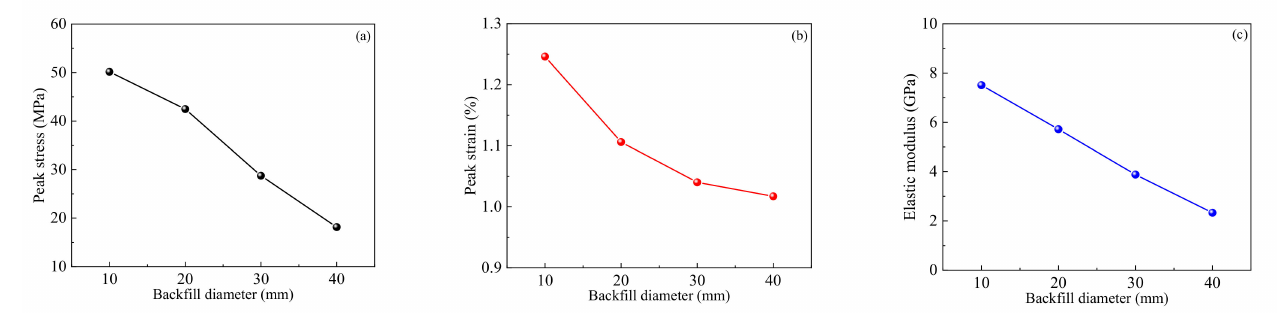
Figure 6. The relationship between the mechanical properties and backfill diameter: ( a ) the σ p ; ( b ) the ε p ; ( c ) the E